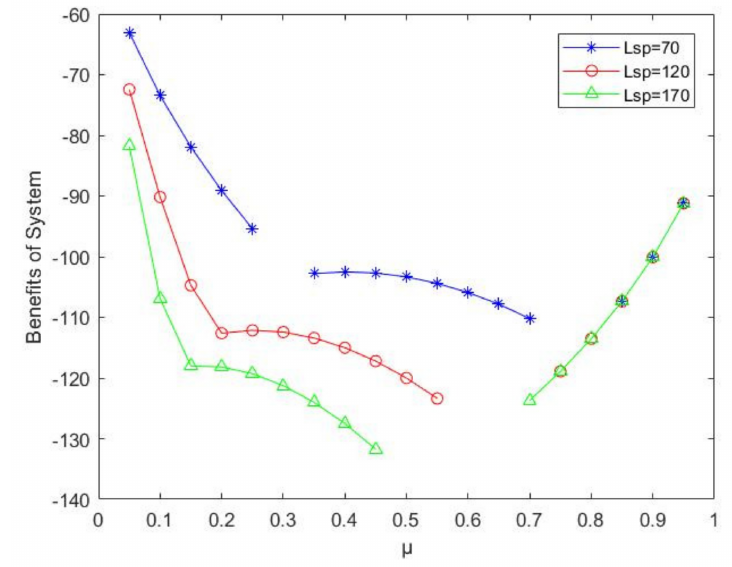
Figure 6. System Incomes under Changes in µ and L